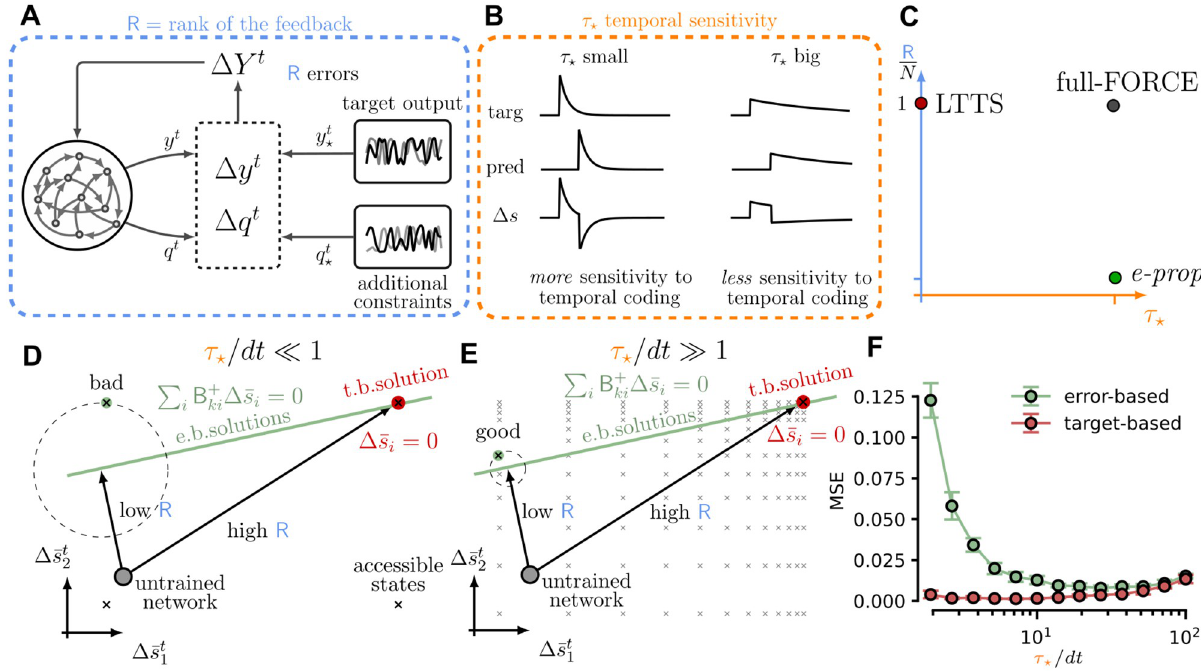
Fig 1. Framework schematics. We propose a general framework where the dimensionality of the error feedback R , and the sensitivity to temporal coding τ ? can be varied arbitrarily. ( A ) Graphical depiction of a general supervised learning framework. R errors (difference between the output and the target output) are projected to the network to evaluate the recurrent weights updates. ( B ) Graphical depiction of the role of the temporal sensitivity parameter τ ? . ( C ) Several learning rules present in the literature (e-prop, full-FORCE, LTTS) can be accounted as specific cases of our general framework. ( D ) Target-based approaches define a specific internal solution for network dynamics (red point), while error-based solutions are distributed in a subspace of possible internal states (green line). However, not all the points on the green line are accessible (given the discrete nature of the spiking activity), and the error-based solution can be sub-optimal. ( E ) However, when τ ? is large, the accessible states are more dense, and it is easier to find a good solution with an error-based approach. ( F ) The MSE for target-based and error-based solutions becomes comparable for large τ ? values. Points are average between five realization of the minimum MSE (after 10 4 training epochs), with error bars denoting the corresponding standard